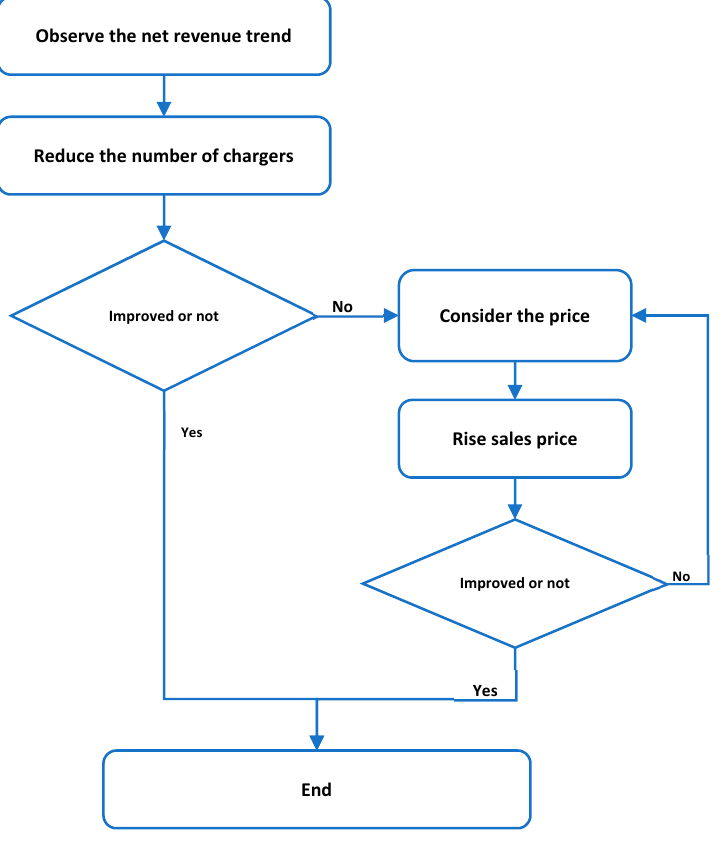
Figure 17. The process of boosting net revenue.